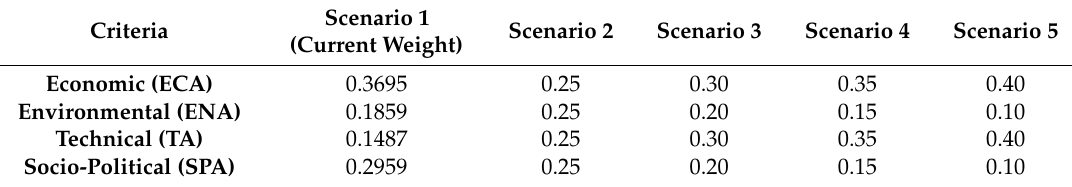
Table 10. Criteria weights employed for sensitivity analysis.